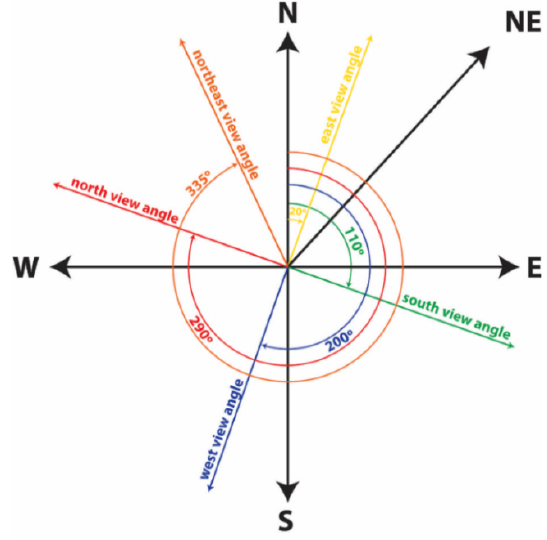
Figure 11. Analysis point view angles (DGI 20